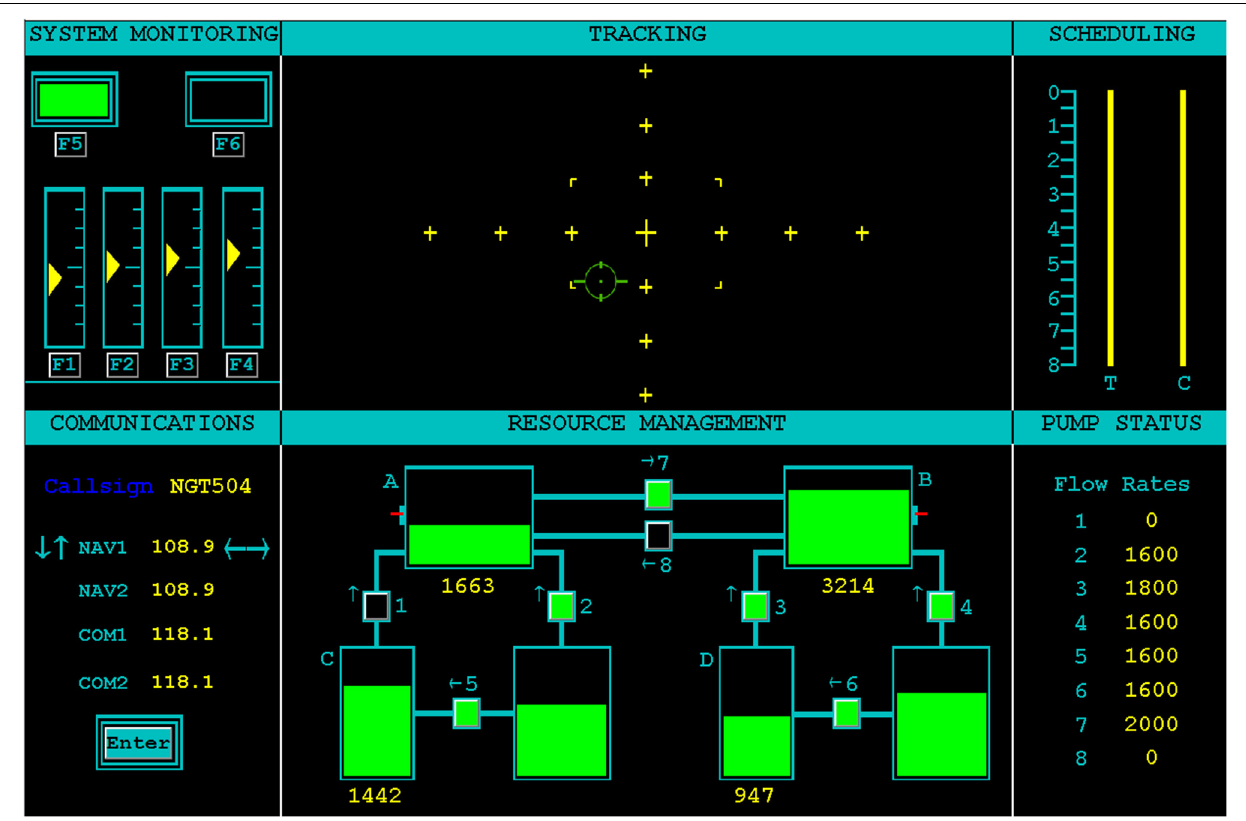
FIGURE 1 | User interface for the AF-MATB task environment. The four subtasks (System Monitoring, Tracking, Communications, and Resource Management) are shown in the left and center columns on the interface. The right column shows Scheduling and Pump Status